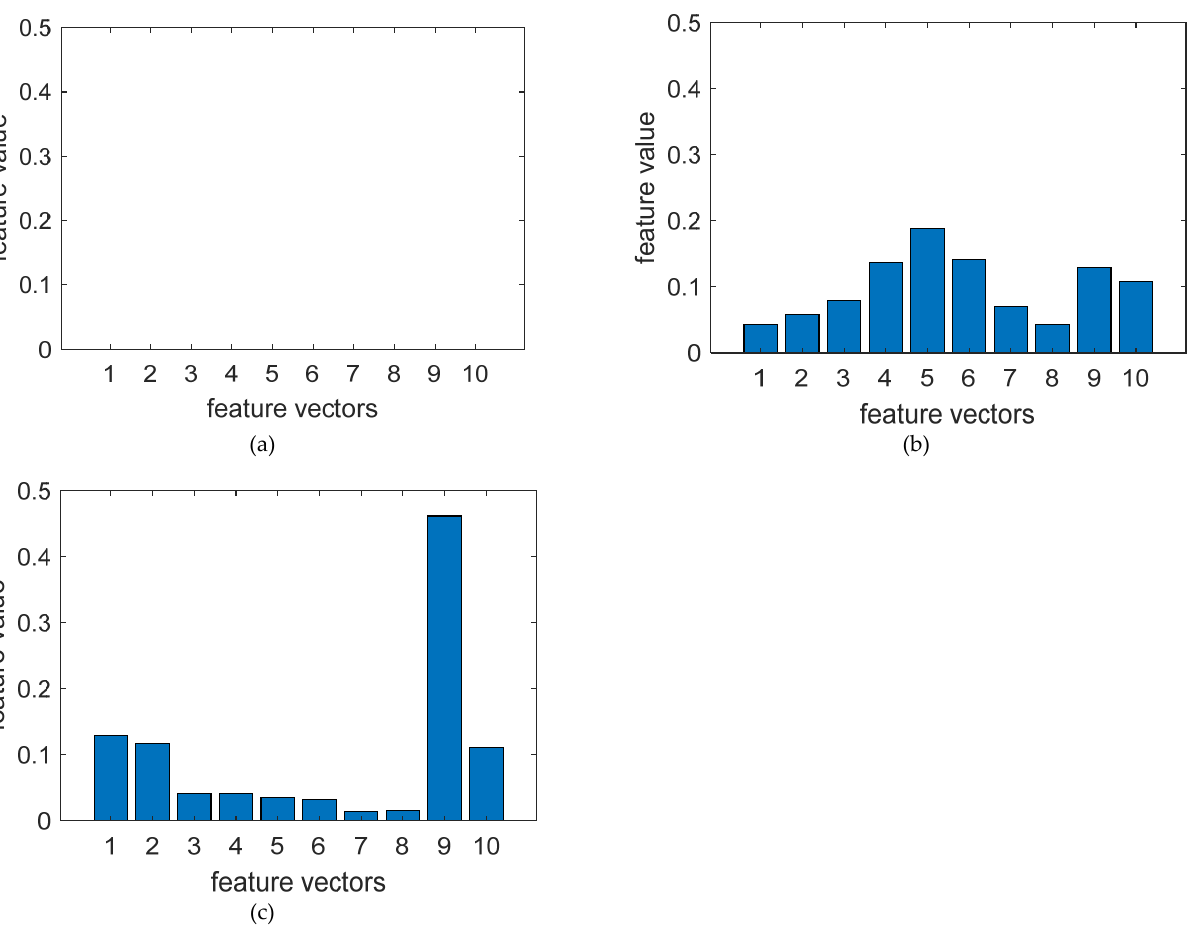
2 riu LBP histograms of forest image ( ) 8,2 ( 8,2 ) histograms of forest image histograms of forest image 2 riu LBP ( 8,2 ) ( ) 8,2 histograms of forest